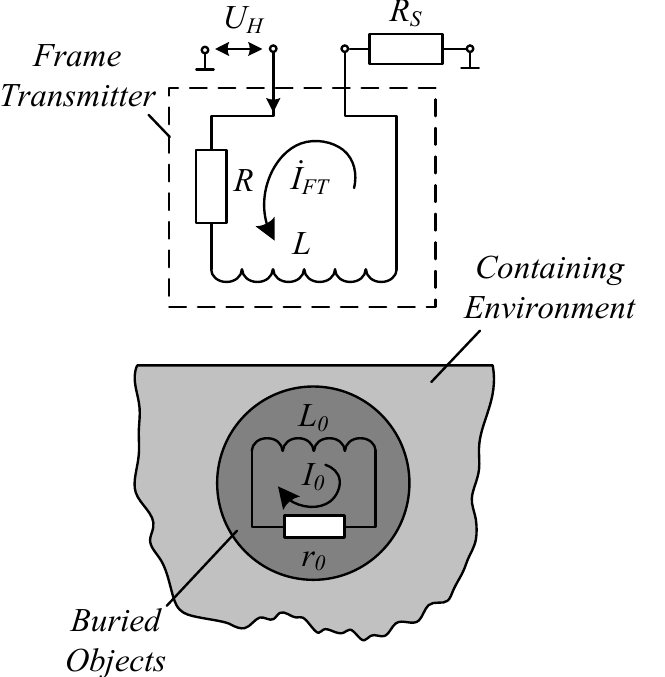
Figure 2. FT interaction with a BO in the containing medium.